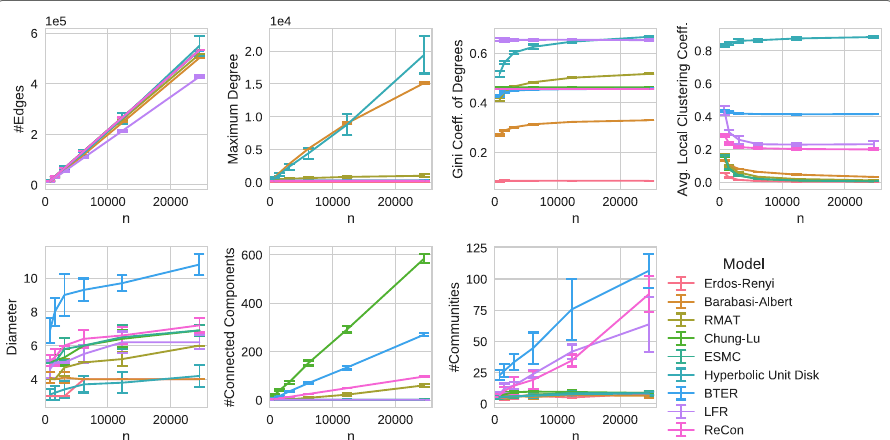
Fig. 4 Scaling behavior of the different generators on the fb-Caltech36 network. From left to right and top to bottom: number of edges, max. degree, Gini coefficient of the degree distribution, average local clustering coefficient, diameter, number of components, number of communities. Each data point is the average over ten runs, the error bars show the standard